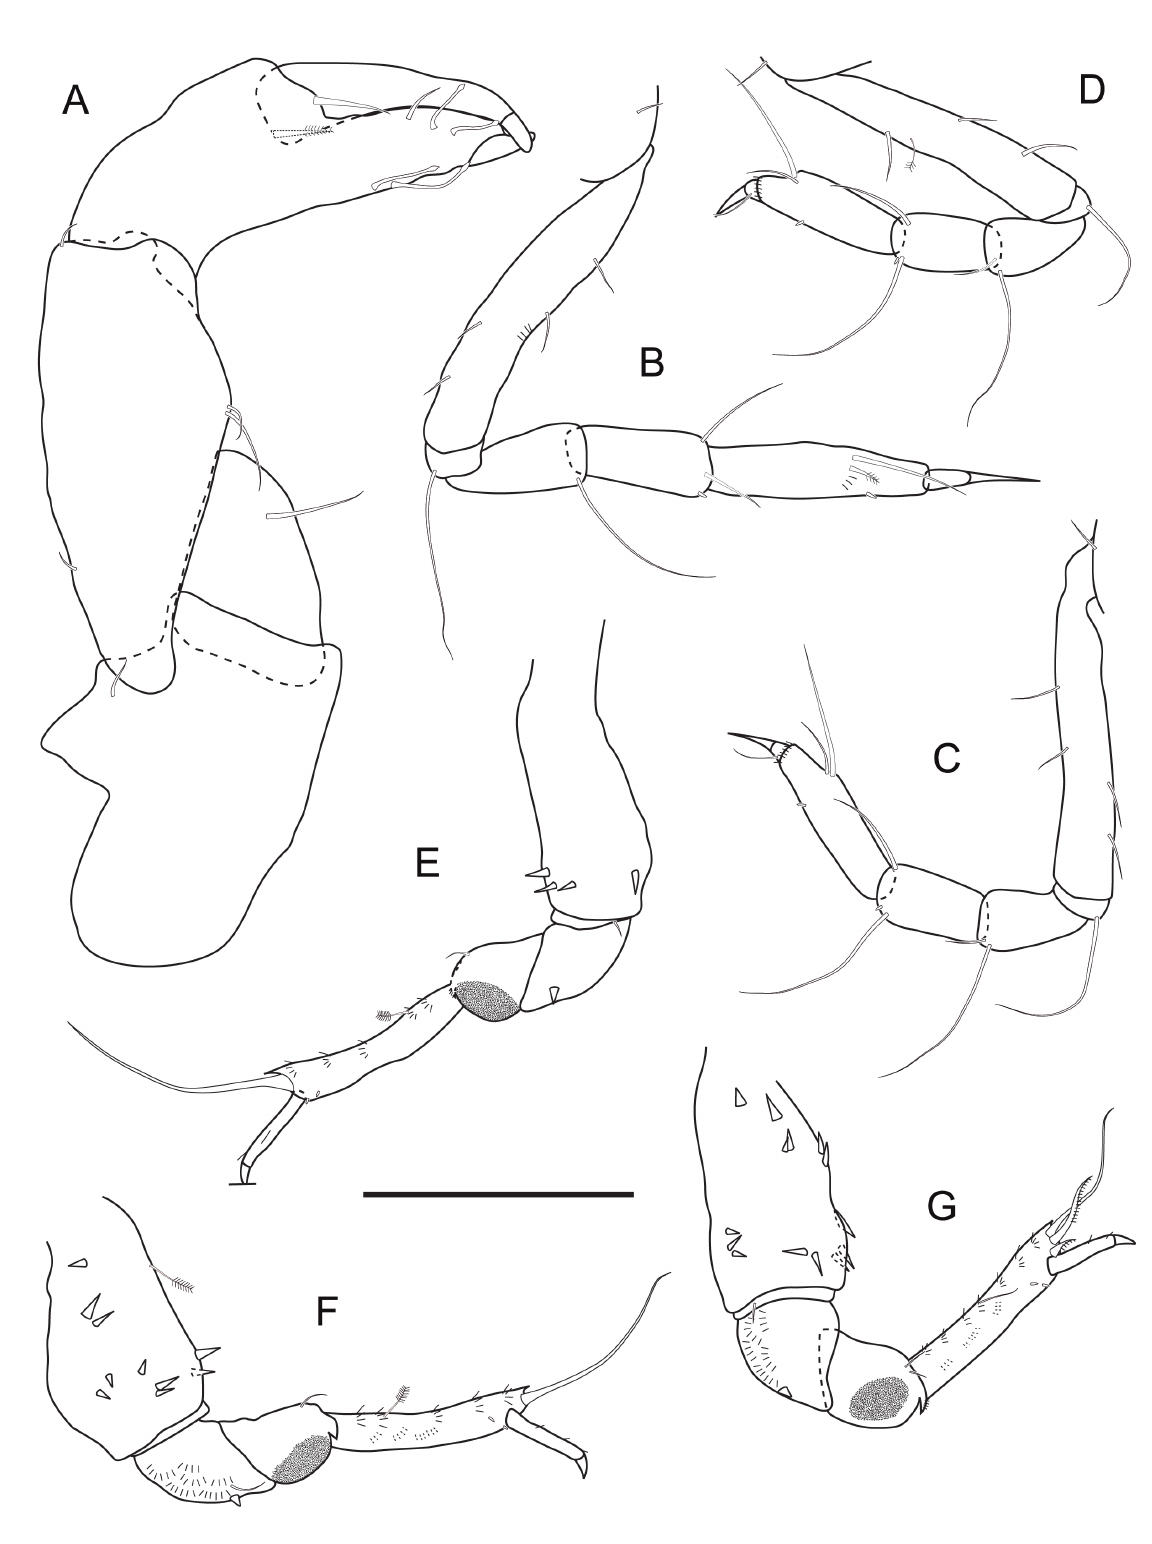
Fig. 20. Typhlotanais spinibasis sp. nov., paratype (MZUSP 38011), ♀, dissected. A . Cheliped. B–G . Pereopods 1–6. Scale bar = 0.1